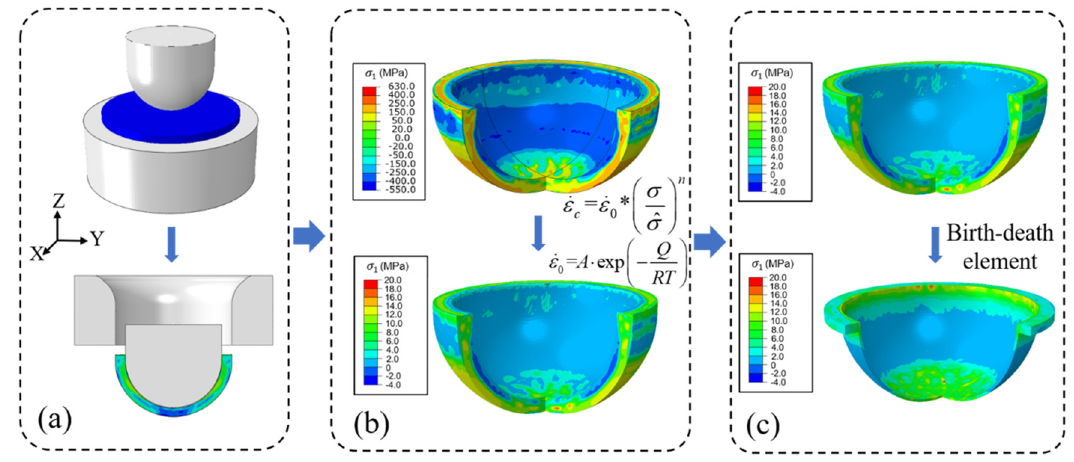
Figure 7: FE model of ( a ) cold - forging, ( b ) annealing heat treatment, and ( c ) material removal processes.